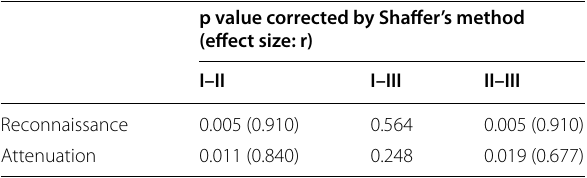
Table 11 P-values based on a comparison for each type